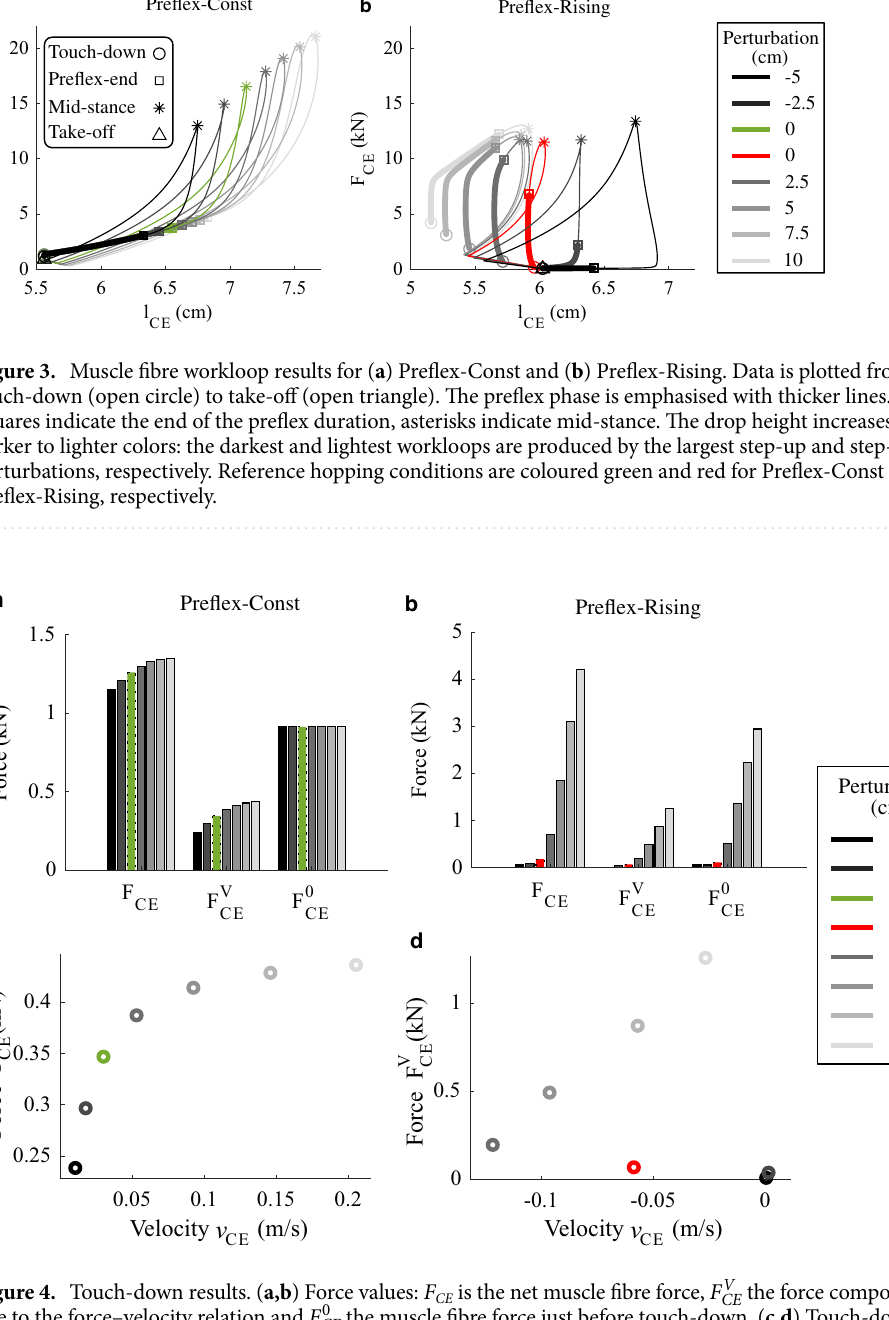
Figure 4. Touch-down results. ( a,b ) Force values: F CE is the net muscle fibre force, F 0 due to the force–velocity relation and F CE the muscle fibre force just before touch-down. ( c,d ) Touch-down dependence of the muscle fibre force component due to the force–velocity relation ( F velocity ( v CE ). ( a,c ) Results for Preflex-Const, with reference hopping condition in green. ( b,d ) Results for Preflex-Rising, with reference hopping condition in